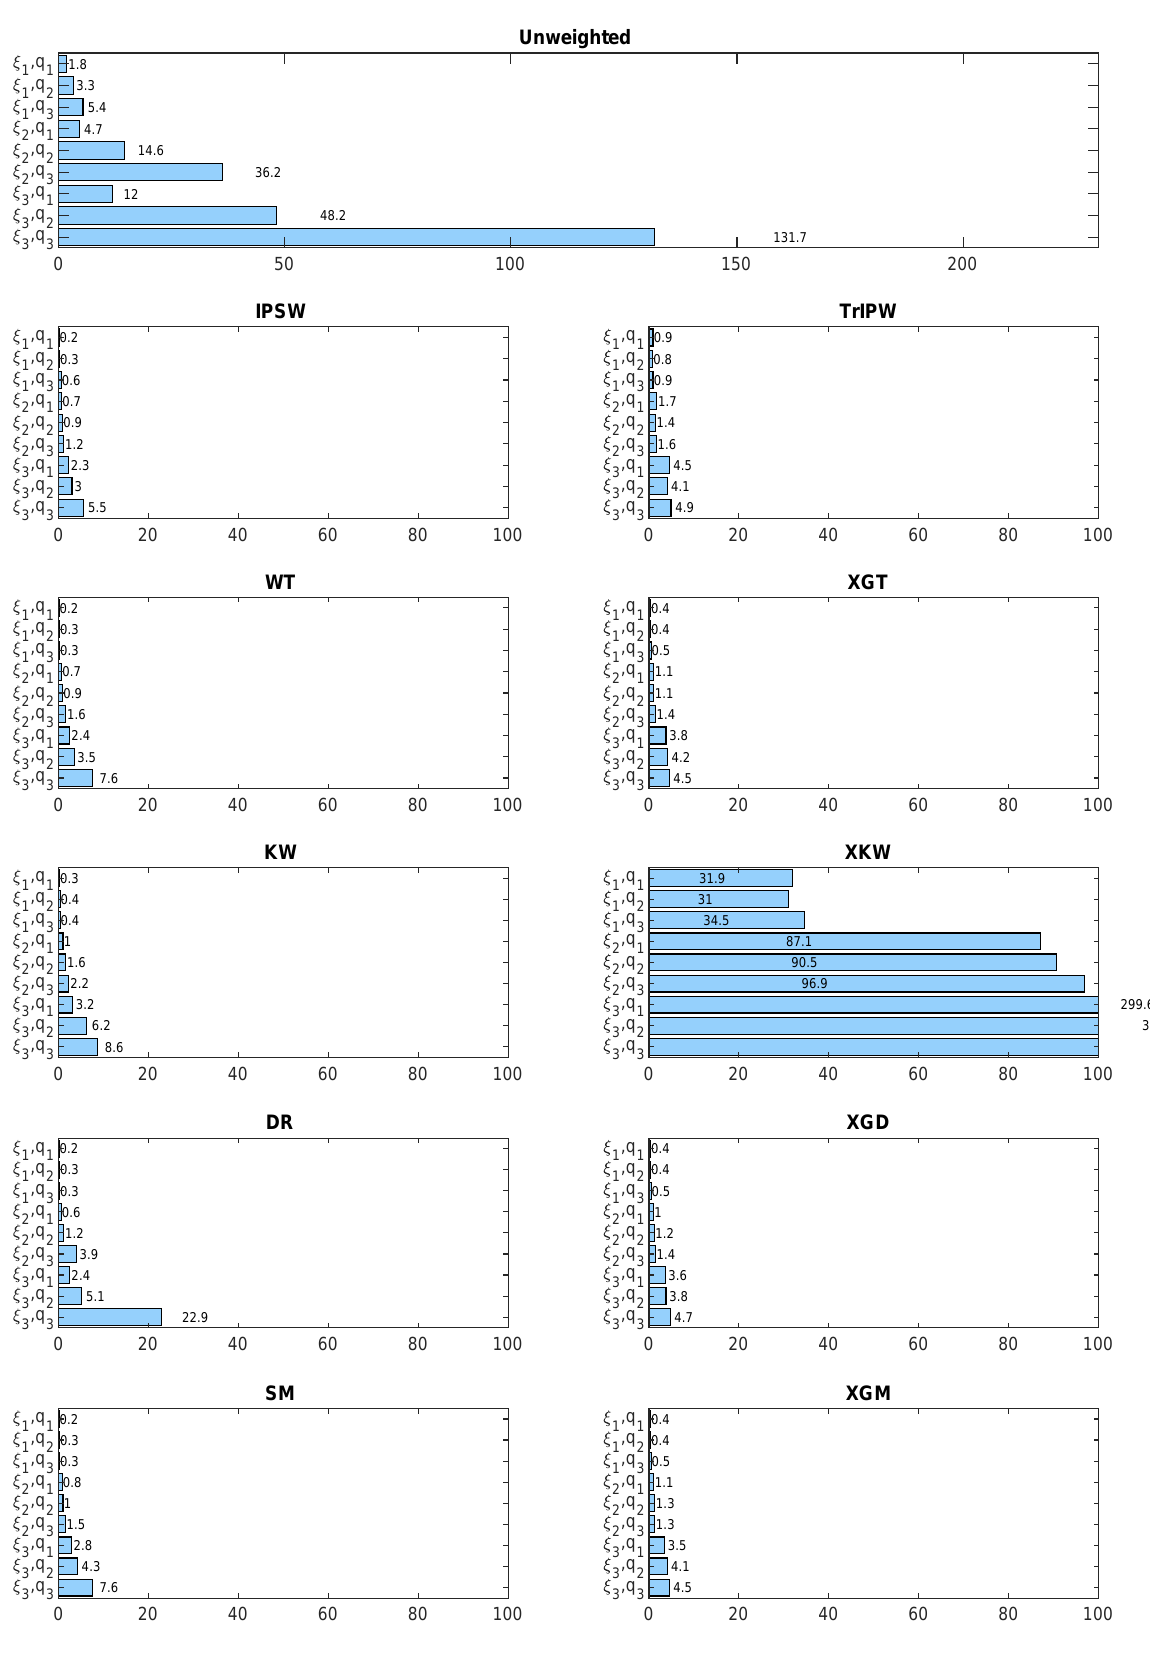
Figure 1. MSE, simulated case, correlation coefficient: